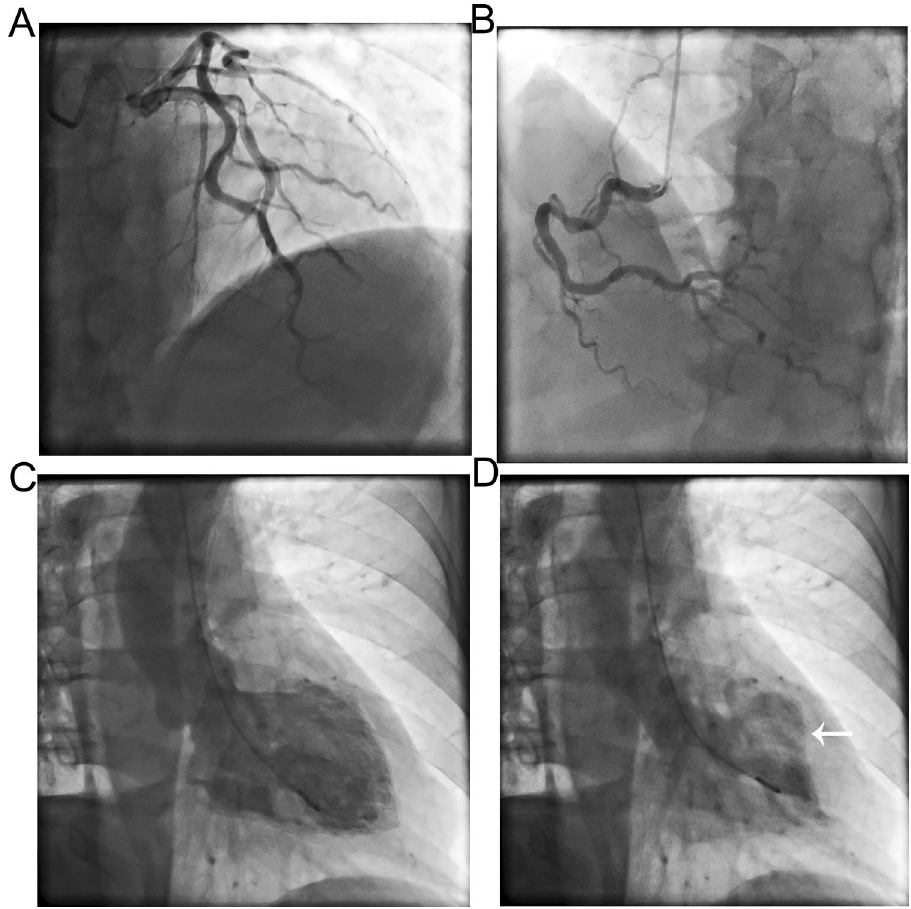
Figure 4. Coronary angiography and left ventriculography of a 55-year old man showing focal TTS. ( A ) Left coronary artery; ( B ) right coronary artery; ( C ) diastolic period; ( D ) systolic period. Arrow points to TTS.